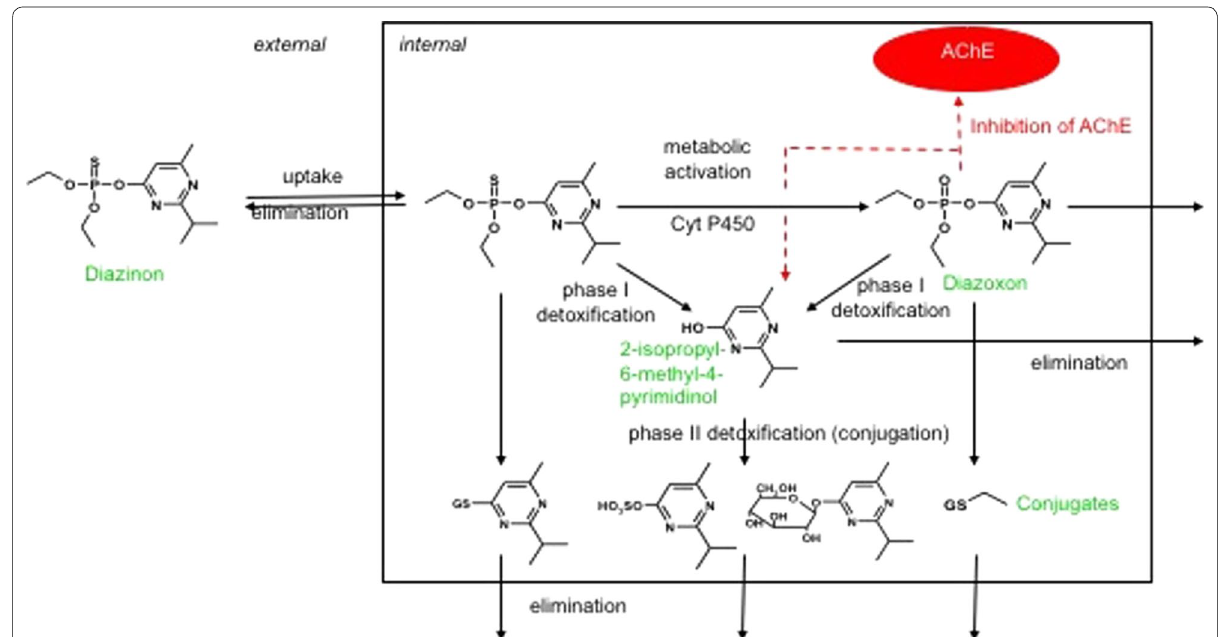
Fig. 2 Mechanism of action of an AChE inhibitor on the example of the insecticide diazinon (simplified from [117]). After oxidation catalysed by cytochrome p450 monooxygenases, Diazinon is metabolized into Diazoxon which can inhibit acetylcholinesterase. Via further phase 1 and phase 2 metabolization steps the molecule is